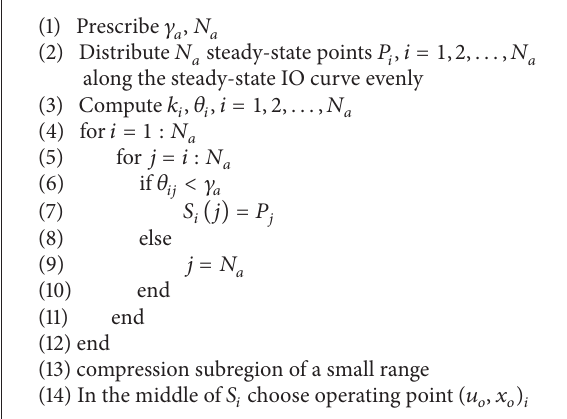
Figure 4: The change of gain of the heat exchanger.